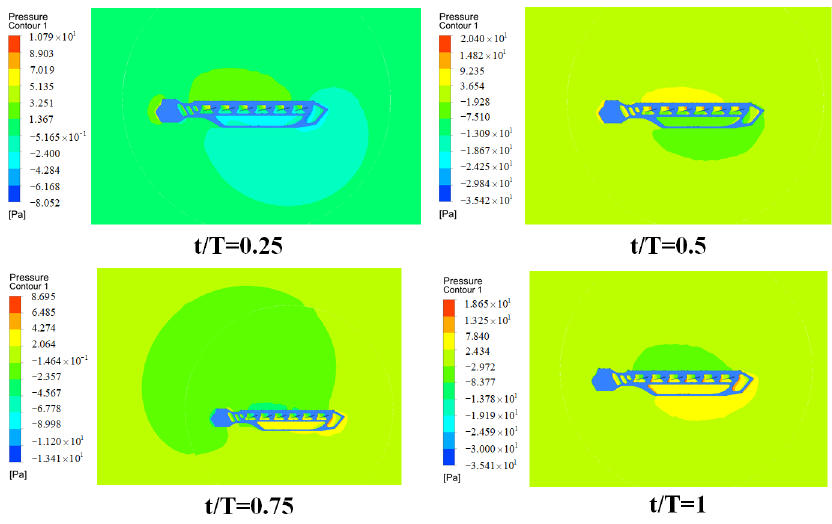
= 15 ◦ ). hf ° θ ). hf (cid:0) (cid:1) ν G and C G RB RB hf